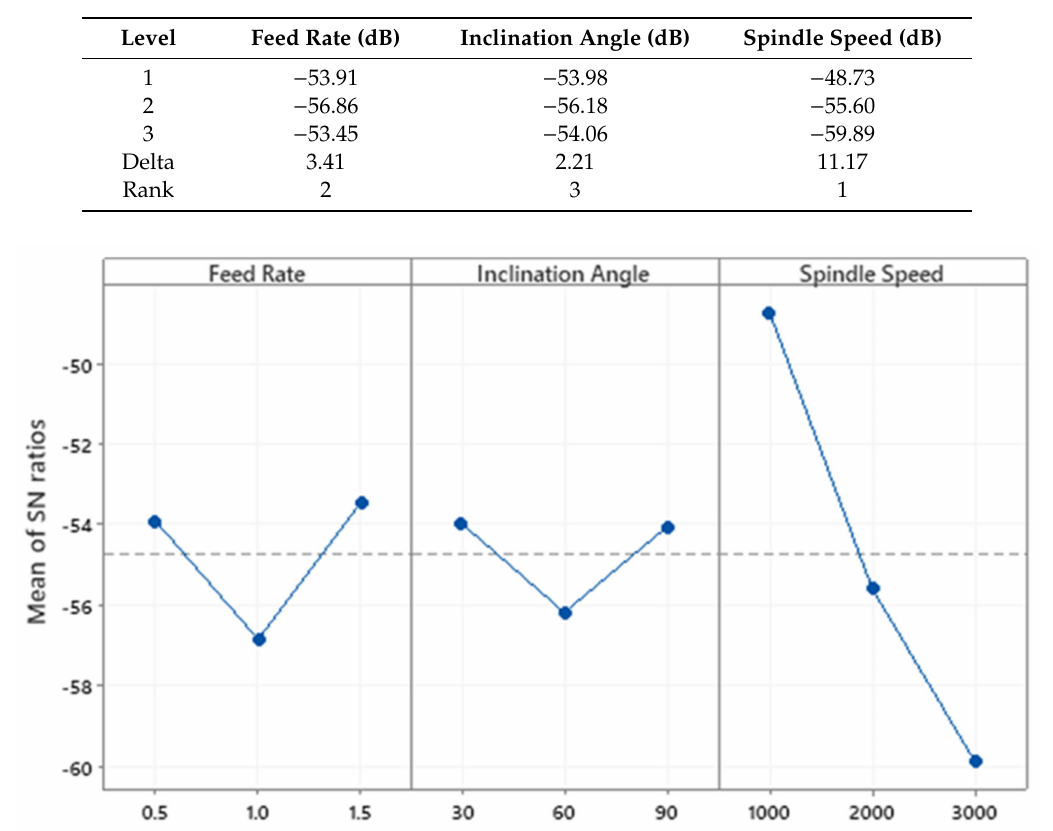
Figure 8. Main e ff ects plot of S / N ratios for